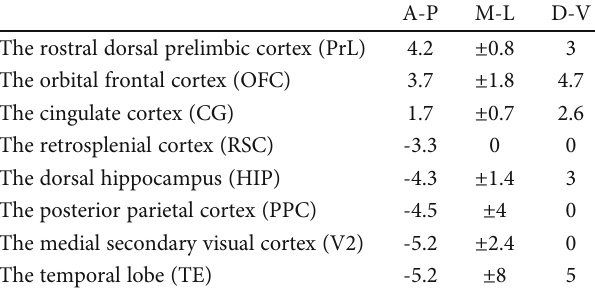
Table 1: Coordinates of the 15 DMN electrodes (mm). A-P, M-L, and D-V indicate the anterior-posterior, medial-lateral, and dorsal-ventral directions,